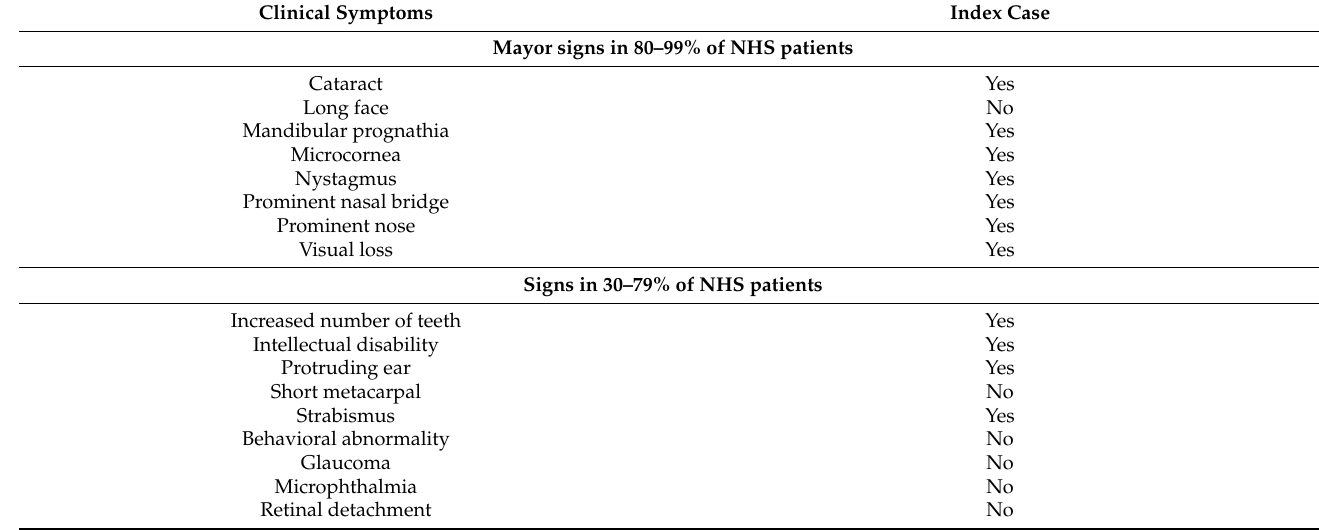
Figure A1. Three-dimensional (3D)-genome map at the Xp22.13. Public Hi-C data from a B-Lymphocyte cell line (GM12878) was used. Breakpoint disrupts TADs boundaries, and gene interactions between regulatory elements on the NHS gene (in blue box). Table A1. Clinical features of the index case correlated to mayor and minor signs of the Nance-Horan